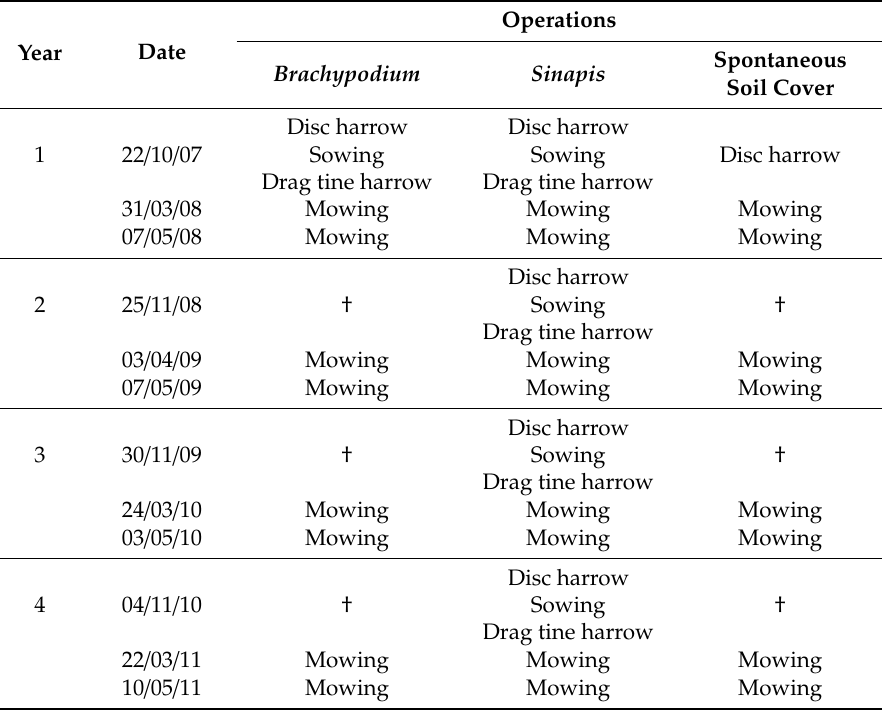
Table 2. Operations carried out in the experimental field.